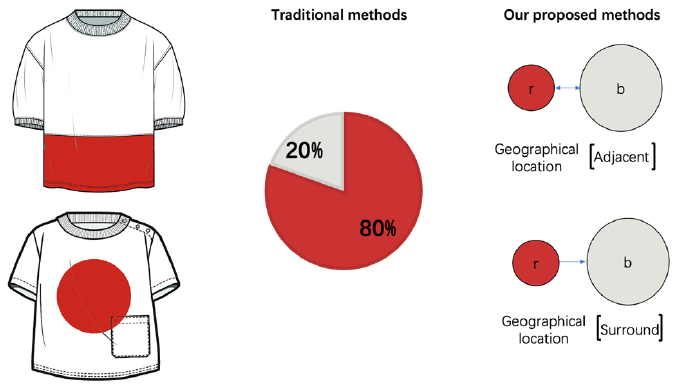
Figure 8. Comparison of graph representation to conventional pie chart for fashion outfits with simple color patterns.